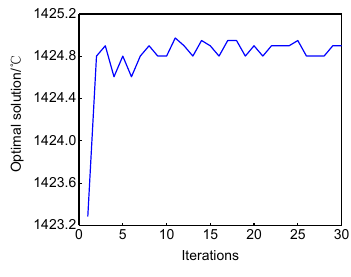
Figure 10. Iteration of optimization by GA.